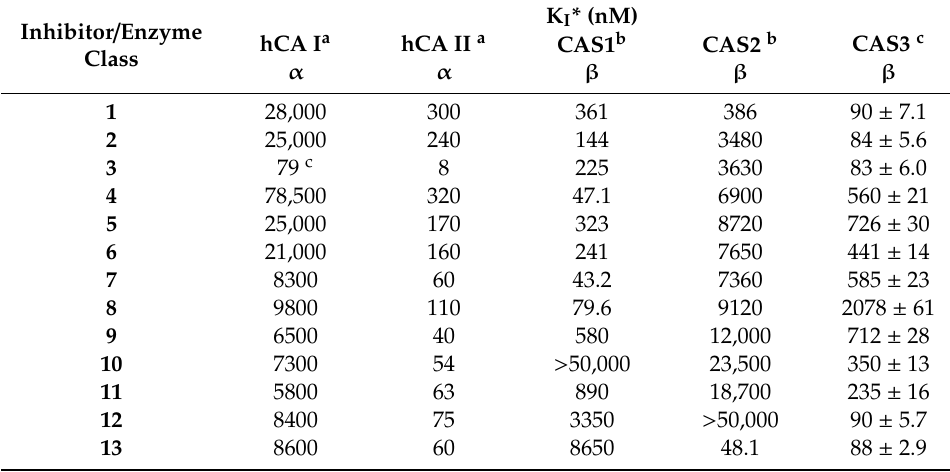
Figure 2. Structure of sulfonamide and sulfamate inhibitors of types 1–24 and AAZ–HCT investigated in the present study. Table 2. Inhibition of human isoforms hCA I and hCA II, and of the β -class fungal enzymes CAS1–CAS3 with sulfonamides 1–24 and the clinically used drugs AAZ–HCT , by a stopped flow CO 2 hydrase assay [24].